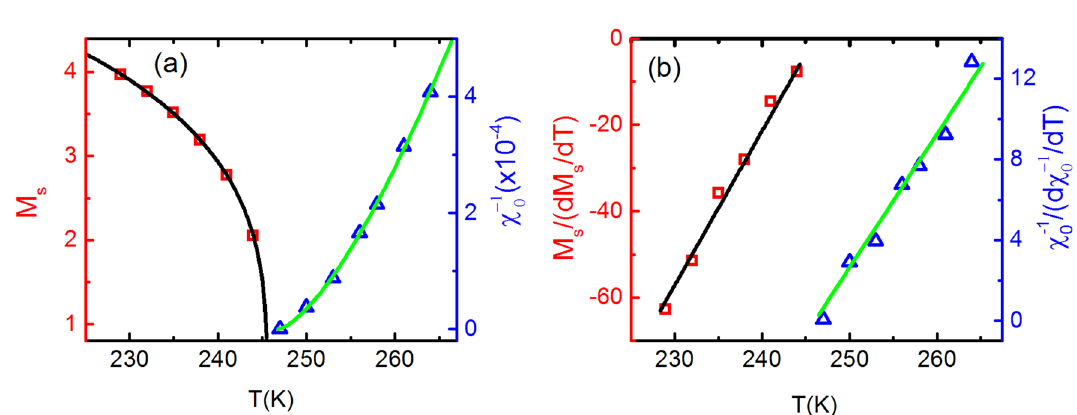
Figure 8. ( a ) The square symbol represents M S versus T plot and the solid curve is its fitting with Eq. (5) which results into β = 0.278. The triangular symbol represents the χ − Eq. (6) which yields γ = 1.48. ( b ) The squares are the M S /( dM S / dT ) versus T plot and the solid curve is its fitting with Eq. (10) which results into β = 0.280. The blue triangle is the χ − green curve is its fitting with Eq. (11) which yields γ =